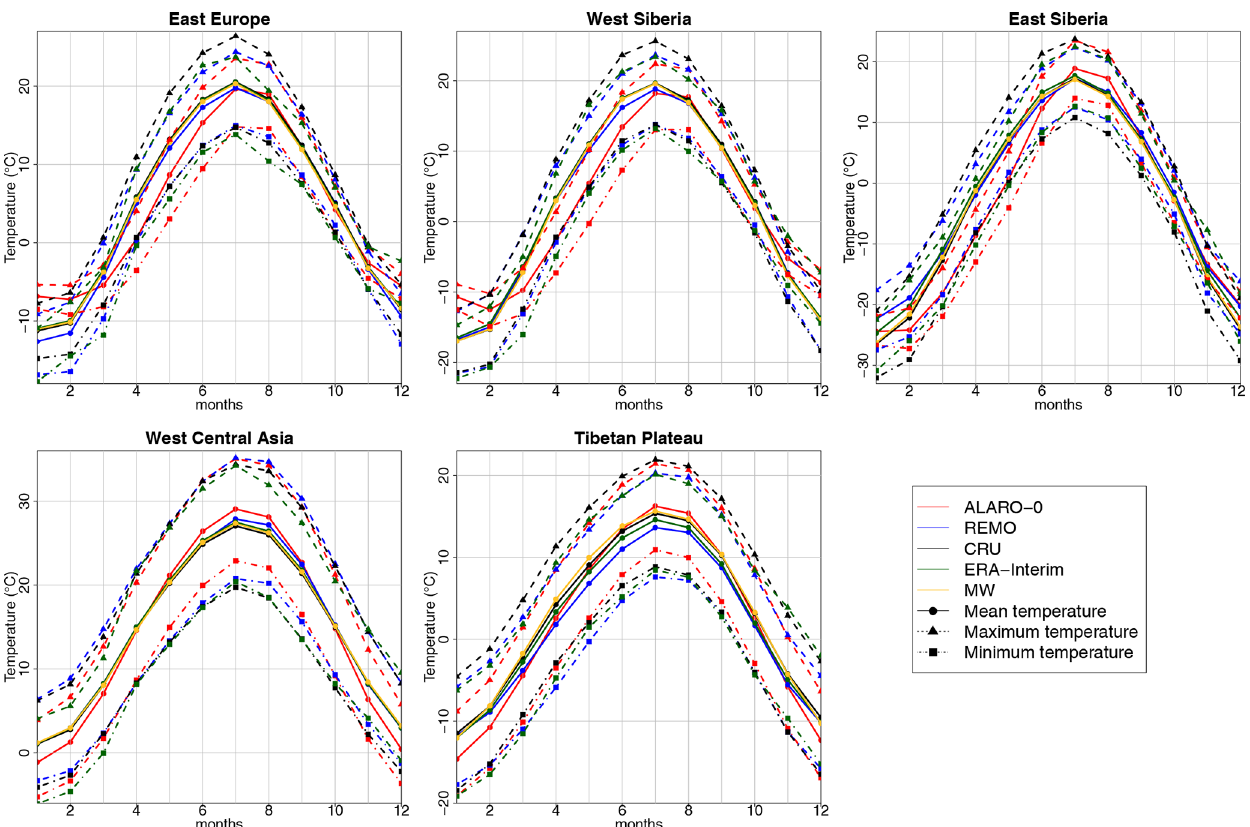
Figure 5. Annual cycles of the mean, minimum, and maximum temperature for both RCMs (ALARO-0 and REMO) compared to the ERA-Interim reanalysis, MW, and CRU observational data over five